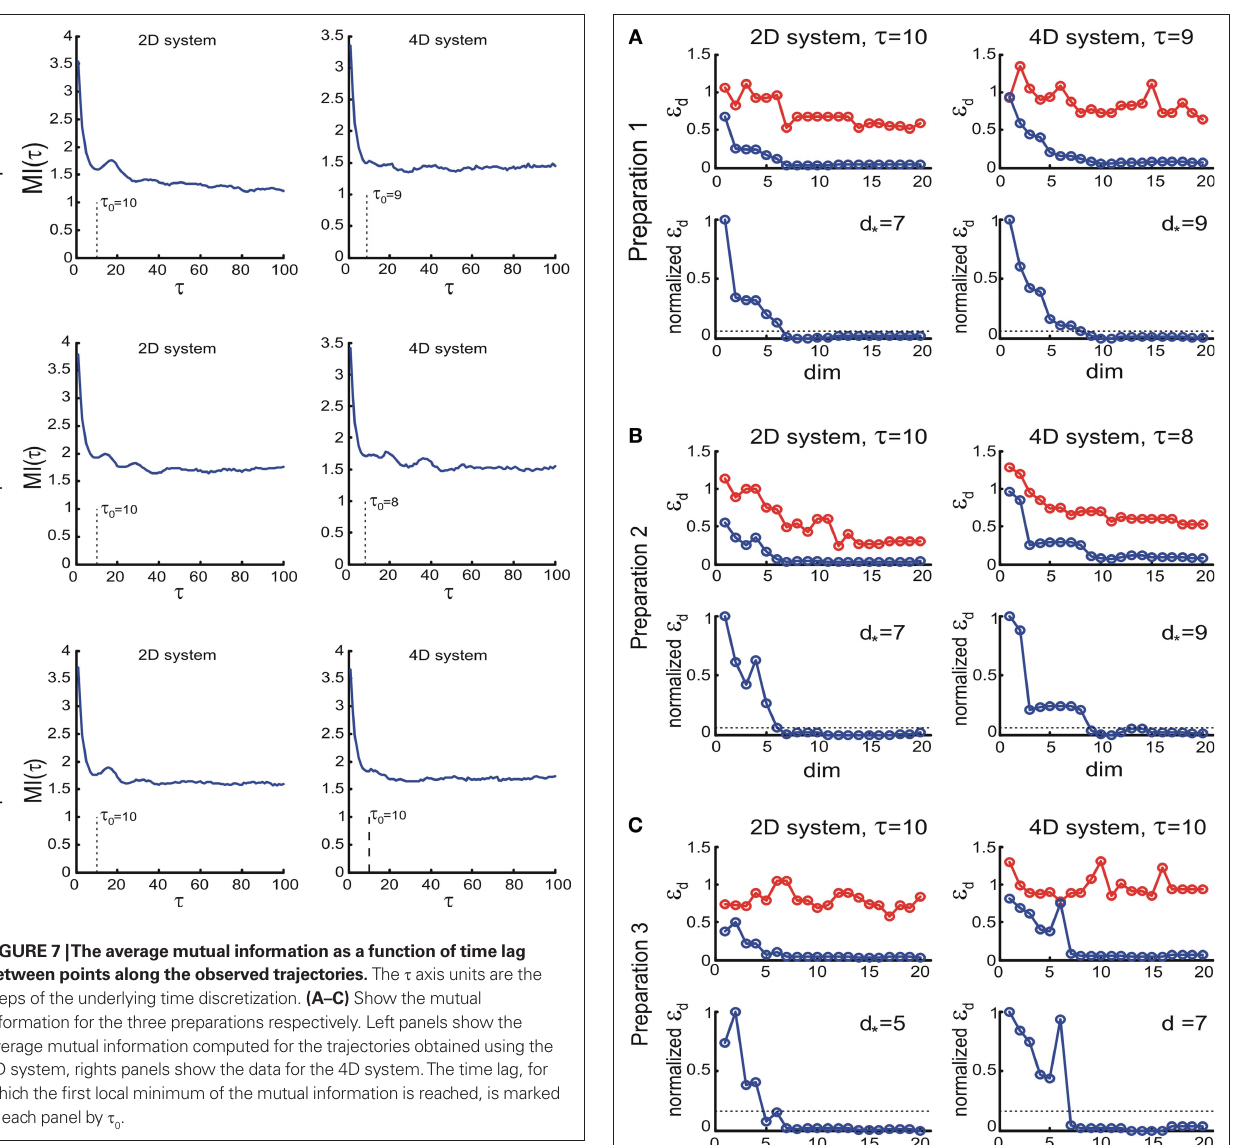
ε FIGURE 8 | ε and ˆ d as a function of d (Eqs 15 and 16). For each d preparation, the left panels show the data collected using the 2D external dynamical system, the right panels show the data collected using the 4D external dynamical system. The red plot in the upper panels show ε computed for surrogate trajectories obtained by randomizing phases of the original trajectories. The dotted line in the lower panels shows the threshold h used to assess the dynamical dimension d *.